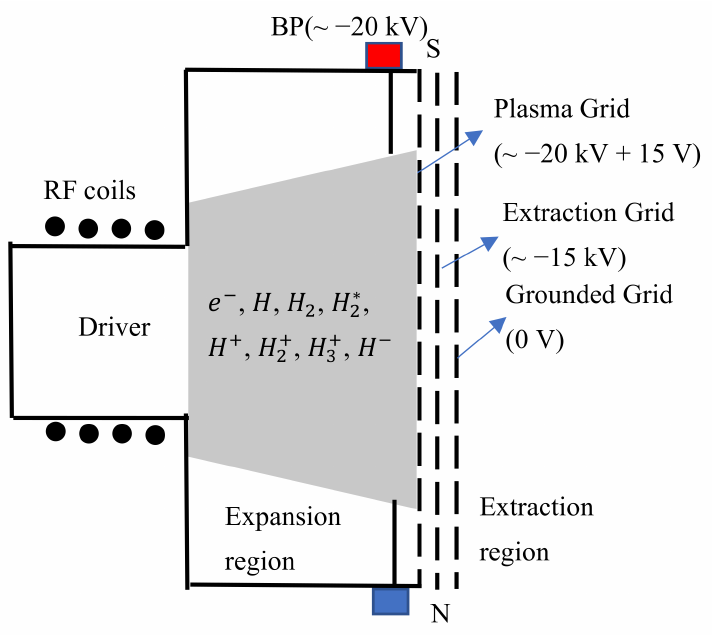
Figure 1. Schematic view of negative hydrogen ion source.